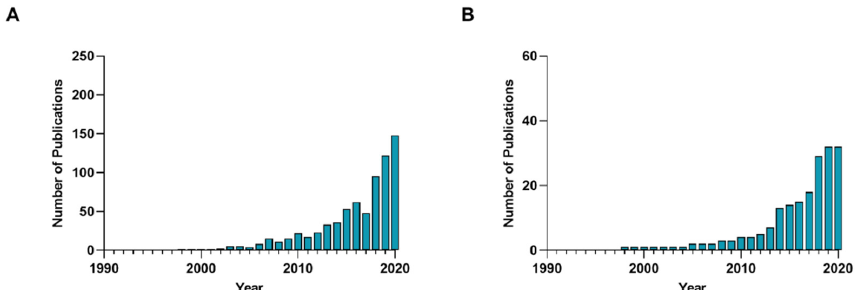
Figure 1. Number of published publications focused on the role of bioactive compound in ( A ) cardiovascular and ( B ) bone health. “Bioactive compounds for cardiovascular health” or “Bioactive compounds for bone health” were the key words used for PubMed searching